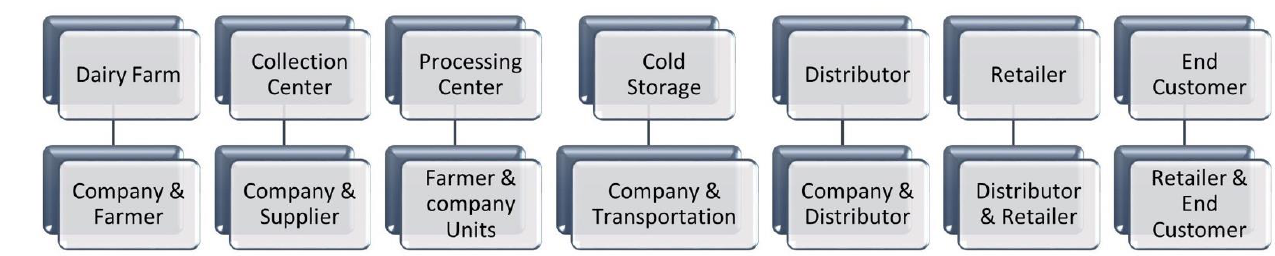
Figure 6. Smart Contract Execution Flow.